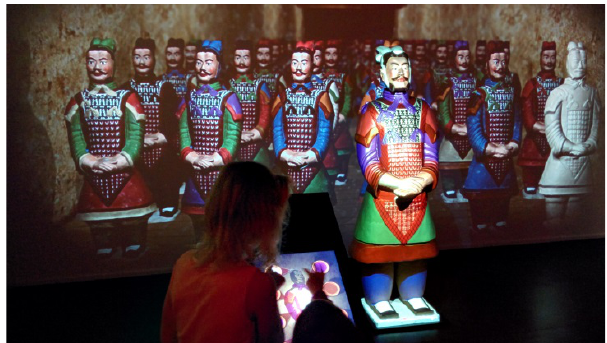
Figure 4. Interactive painting installation. On the touchscreen, parts and colours to manipulate on the physical terracotta warrior (copy) are selected. When the warrior is painted, this goes into flames, and occurs in the long line of painted warriors on the projection in the background. Moesgaard Museum, Denmark. Photo: The author.